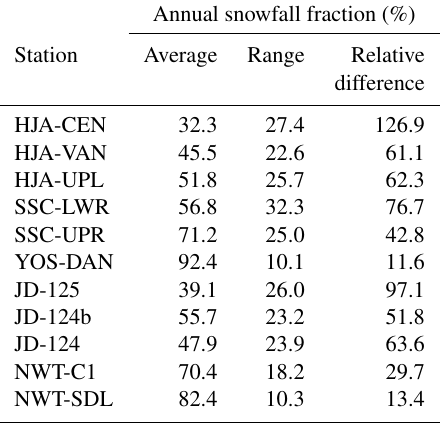
Figure 8. Example simulation years from a selection of stations showing pronounced differences in peak SWE magnitude (a) , peak SWE date and snowmelt rate (b) , and snow cover duration (c) . Panel (d) exemplifies a site and year with little divergence in the studied snowpack metrics. In all panels simulated SWE and snow depth are represented by colored lines for the different methods, while observed SWE and snow depth are shown in